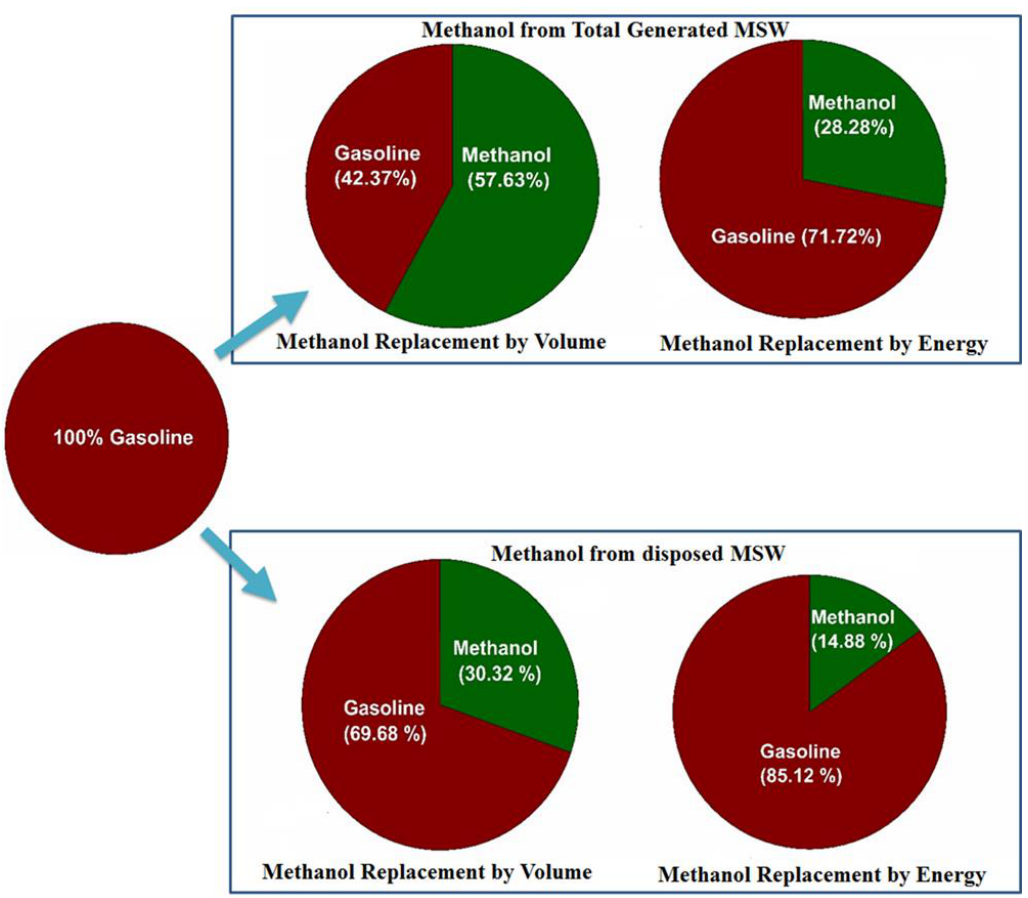
Figure 11. Replacement potential diagram of bio methanol from municipal solid waste.